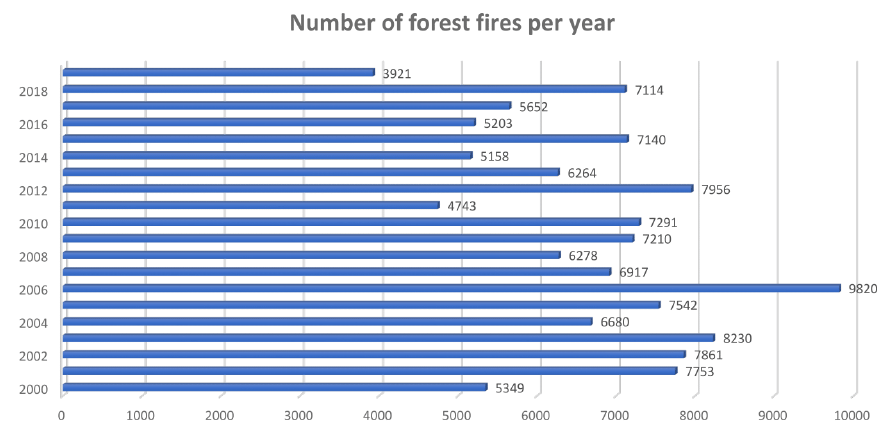
Figure 4. Number of forest fires in Canada from 2000 to